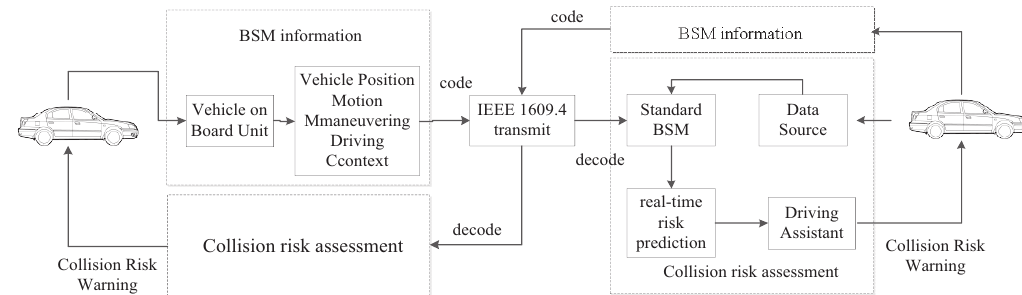
Figure 1 Schematics of connected vehicle safety applications